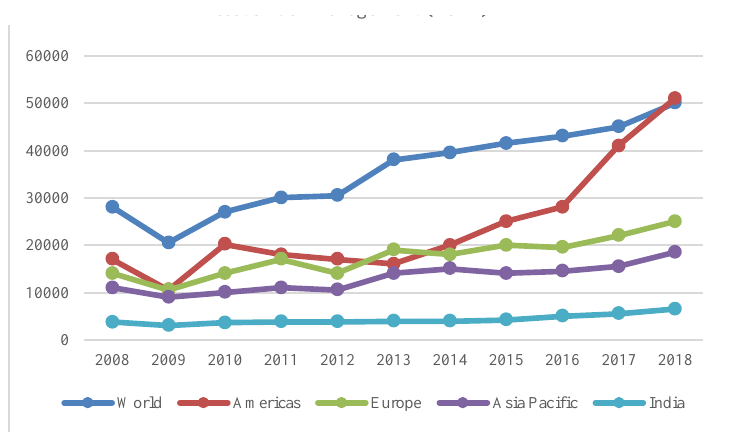
Fig.1: Asset under management; Source: International Investment Funds Association (IIFA) **Data pertains to the first quarter of the respective calendar years for open-ended funds